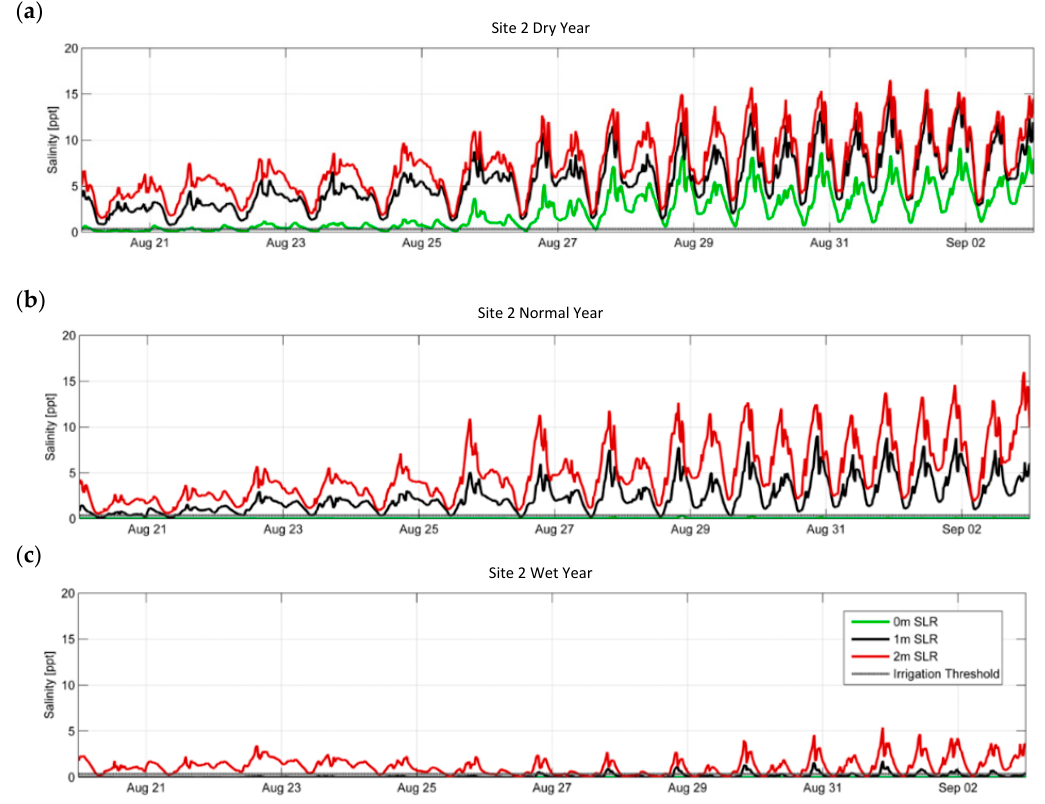
Figure 15. Surface salinity at site 2 in August with 0–2 m SLR: ( a ) dry year; ( b ) normal year; ( c ) wet year.